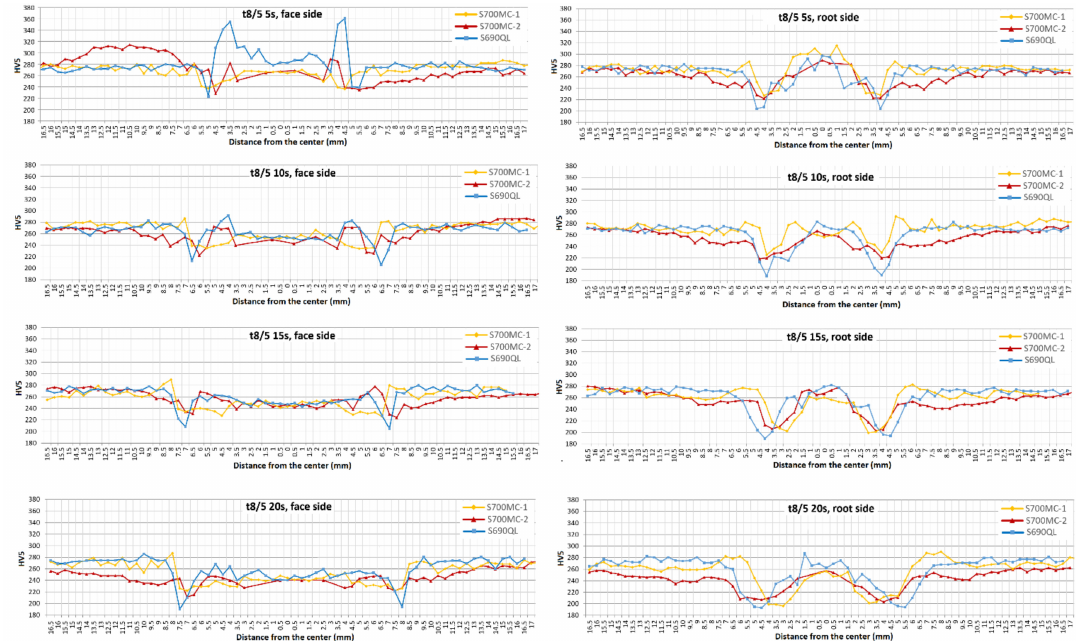
Figure 12. Hardness profiles of the welds of different materials with four different heat